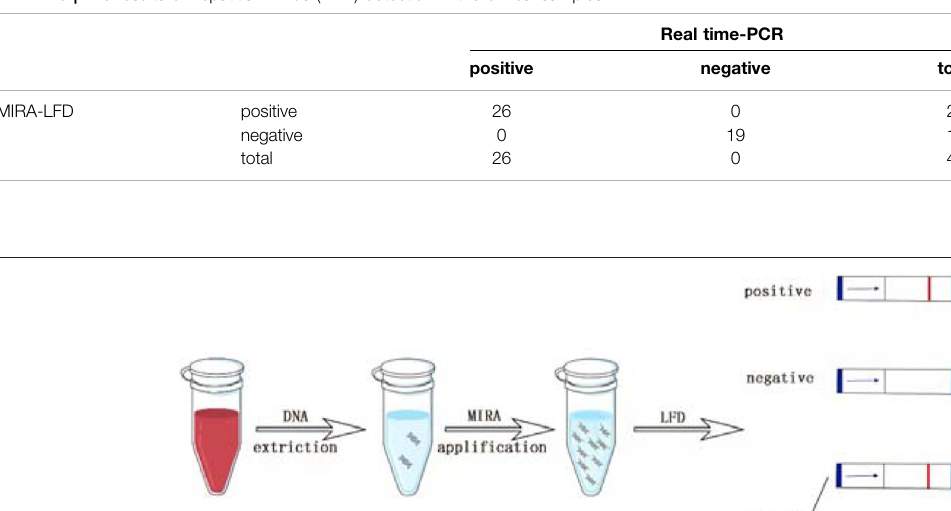
TABLE 3 | The results of hepatitis B virus (HBV) detection in the clinical samples.